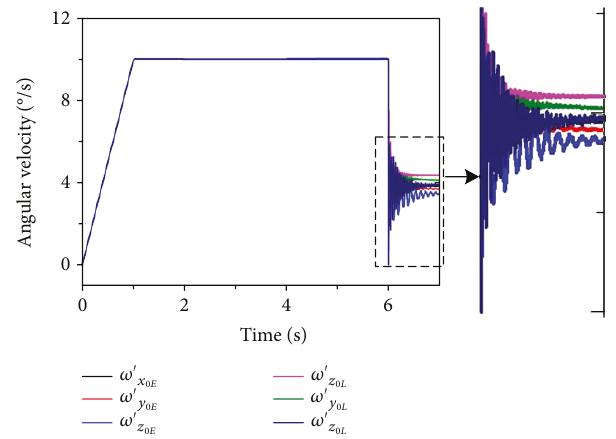
Figure 6: The disturbance angular